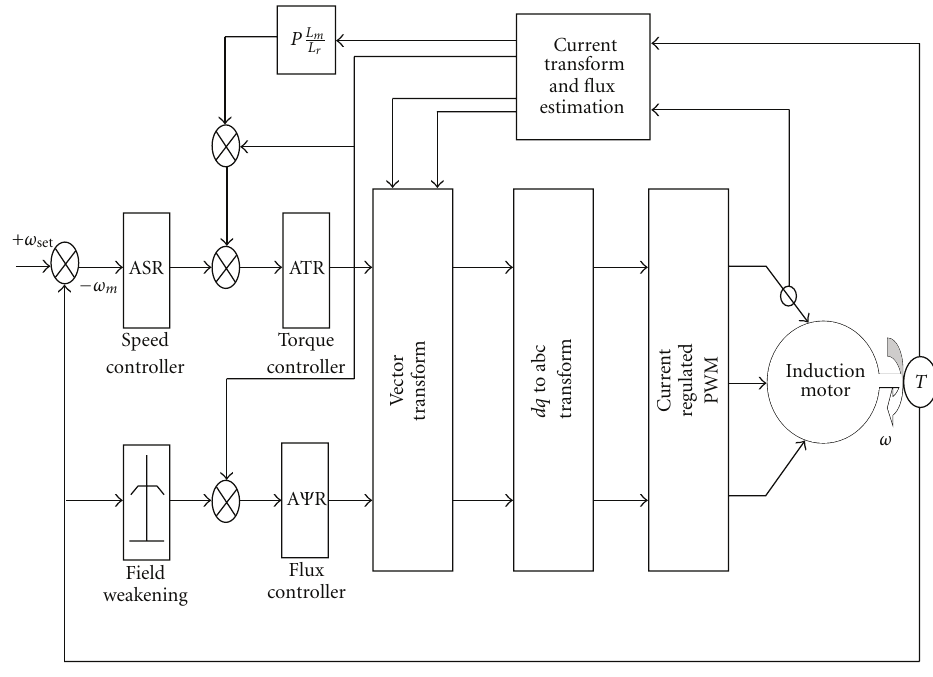
Figure 2: The vector control system for driving motor.